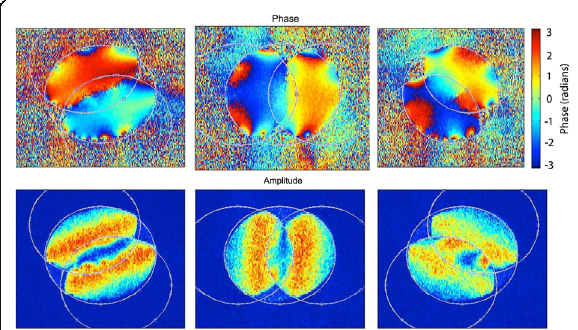
Fig. 7 Ptychographic reconstructions of phase and amplitude components for three spatial frequencies in graphene showing strong contribution from the regions of double overlap. Reproduced from Pennycook et al. 2015. Copyright 2015 with permission from Elsevier